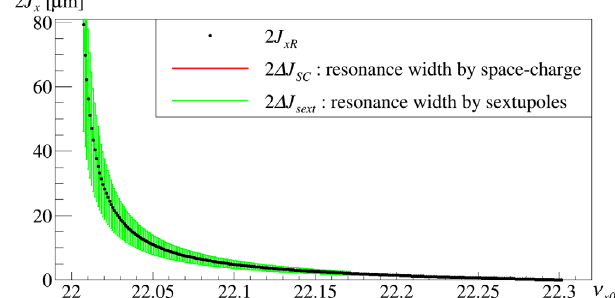
FIG. 13. The on-resonance actions 2 J xR and the resonance widths in the NX21 experiment as a function of the bare tune obtained from the analytical calculations. The horizontal axis represents the bare horizontal tune. The black points represent the on-resonance actions 2 J xR , red lines represent the resonance widths due to the space-charge effect 2 Δ J SC , and the green lines represent the resonance widths due to the sextupoles 2 Δ J